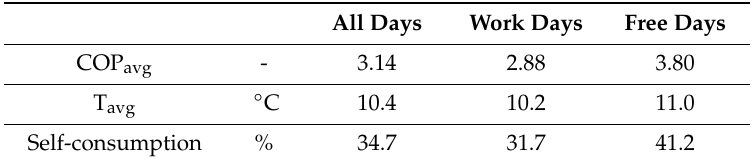
Table 6. Calculation parameter for year period.